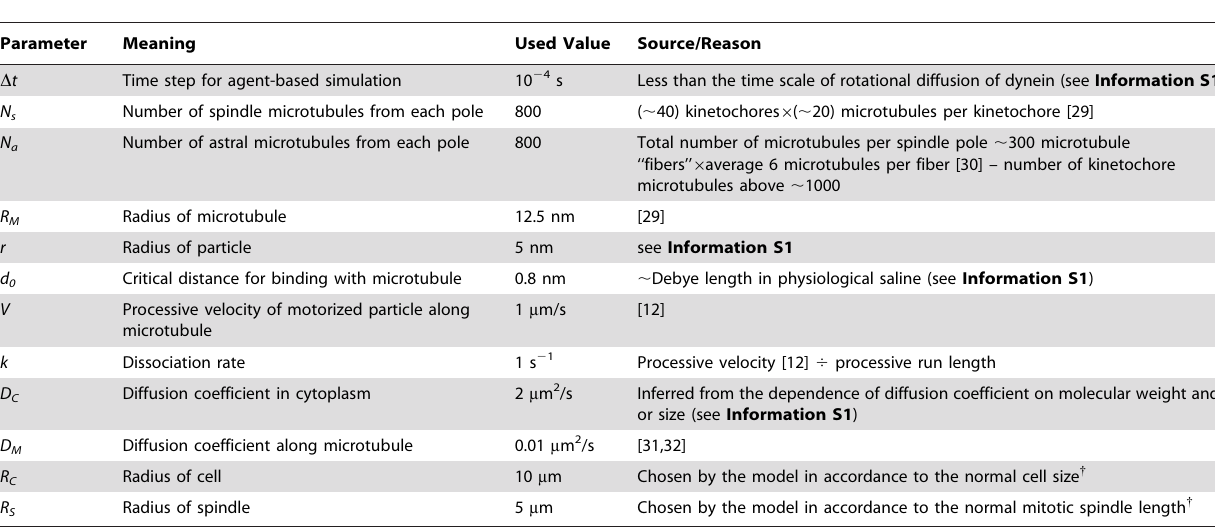
Table 1. Parameters used to simulate the dynein-mediated transport by microtubule spindle.